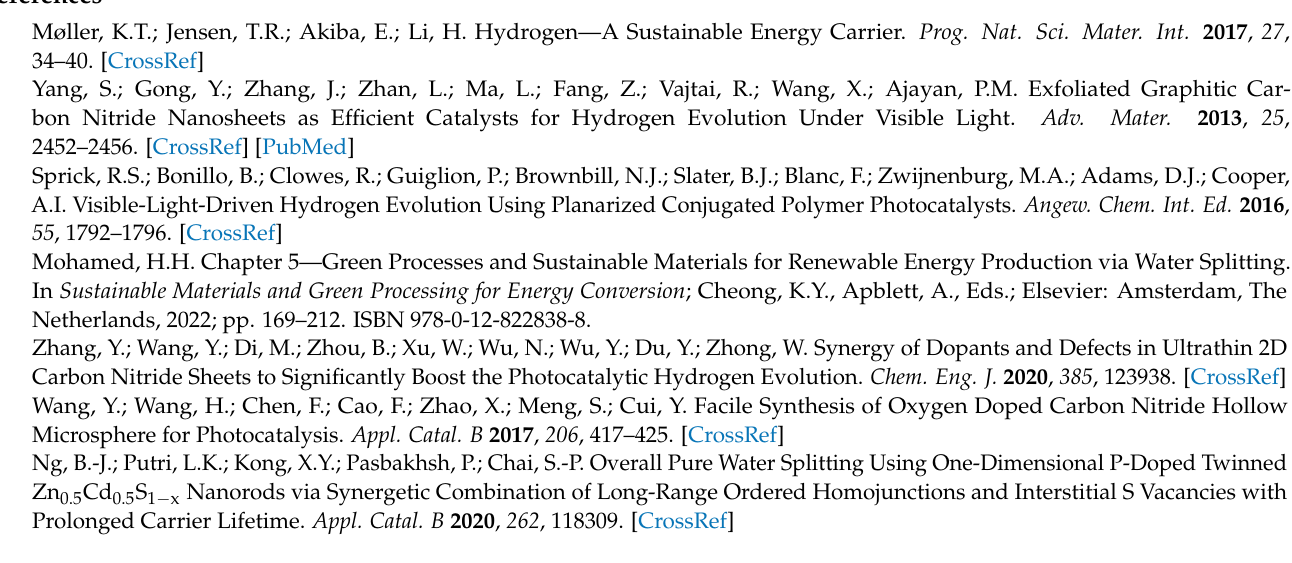
Figure S1: The photoluminescence spectra of GCN and ACN; Figure S2: Field Emission Scanning Electron Microscopy of GCN. Figure S3: The photocatalytic H 2 production rate over 6 hours dura- tion by GCN and ACN in (a) simulated seawater under optimum conditions calculated from RSM (2.55 g/L catalyst loading, 17.46 vol% TEOA and 45.06 g/L salinity); (b) pure water (0.75 g/L catalyst loading, 10 vol% TEOA and 0 g/L salinity); Figure S4: Plots of (a) optimum TEOA concentration against catalyst loading at 3 levels of sea salt content ( − 1, 0, +1); (b) optimum sea salt content against catalyst loading at 3 levels of TEOA concentration (+1, 0, − 1); (c) optimum sea salt content against TEOA concentration at 3 levels of catalyst loading (+1, 0, − 1); Figure S5: H 2 yield rate in 6 hours for 3 consecutive runs (Run 1 − 3) under optimum conditions (2.55 g/L catalyst loading, 17.46 vol% TEOA and 45.06 g/L